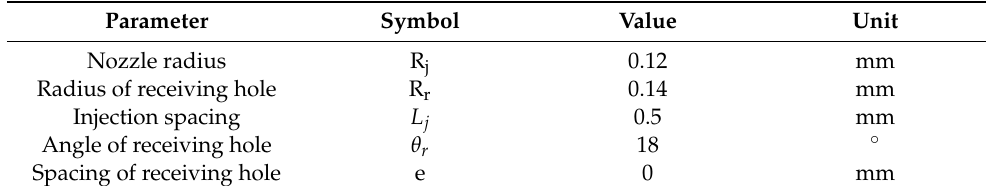
Table 1. Key structural parameter table.